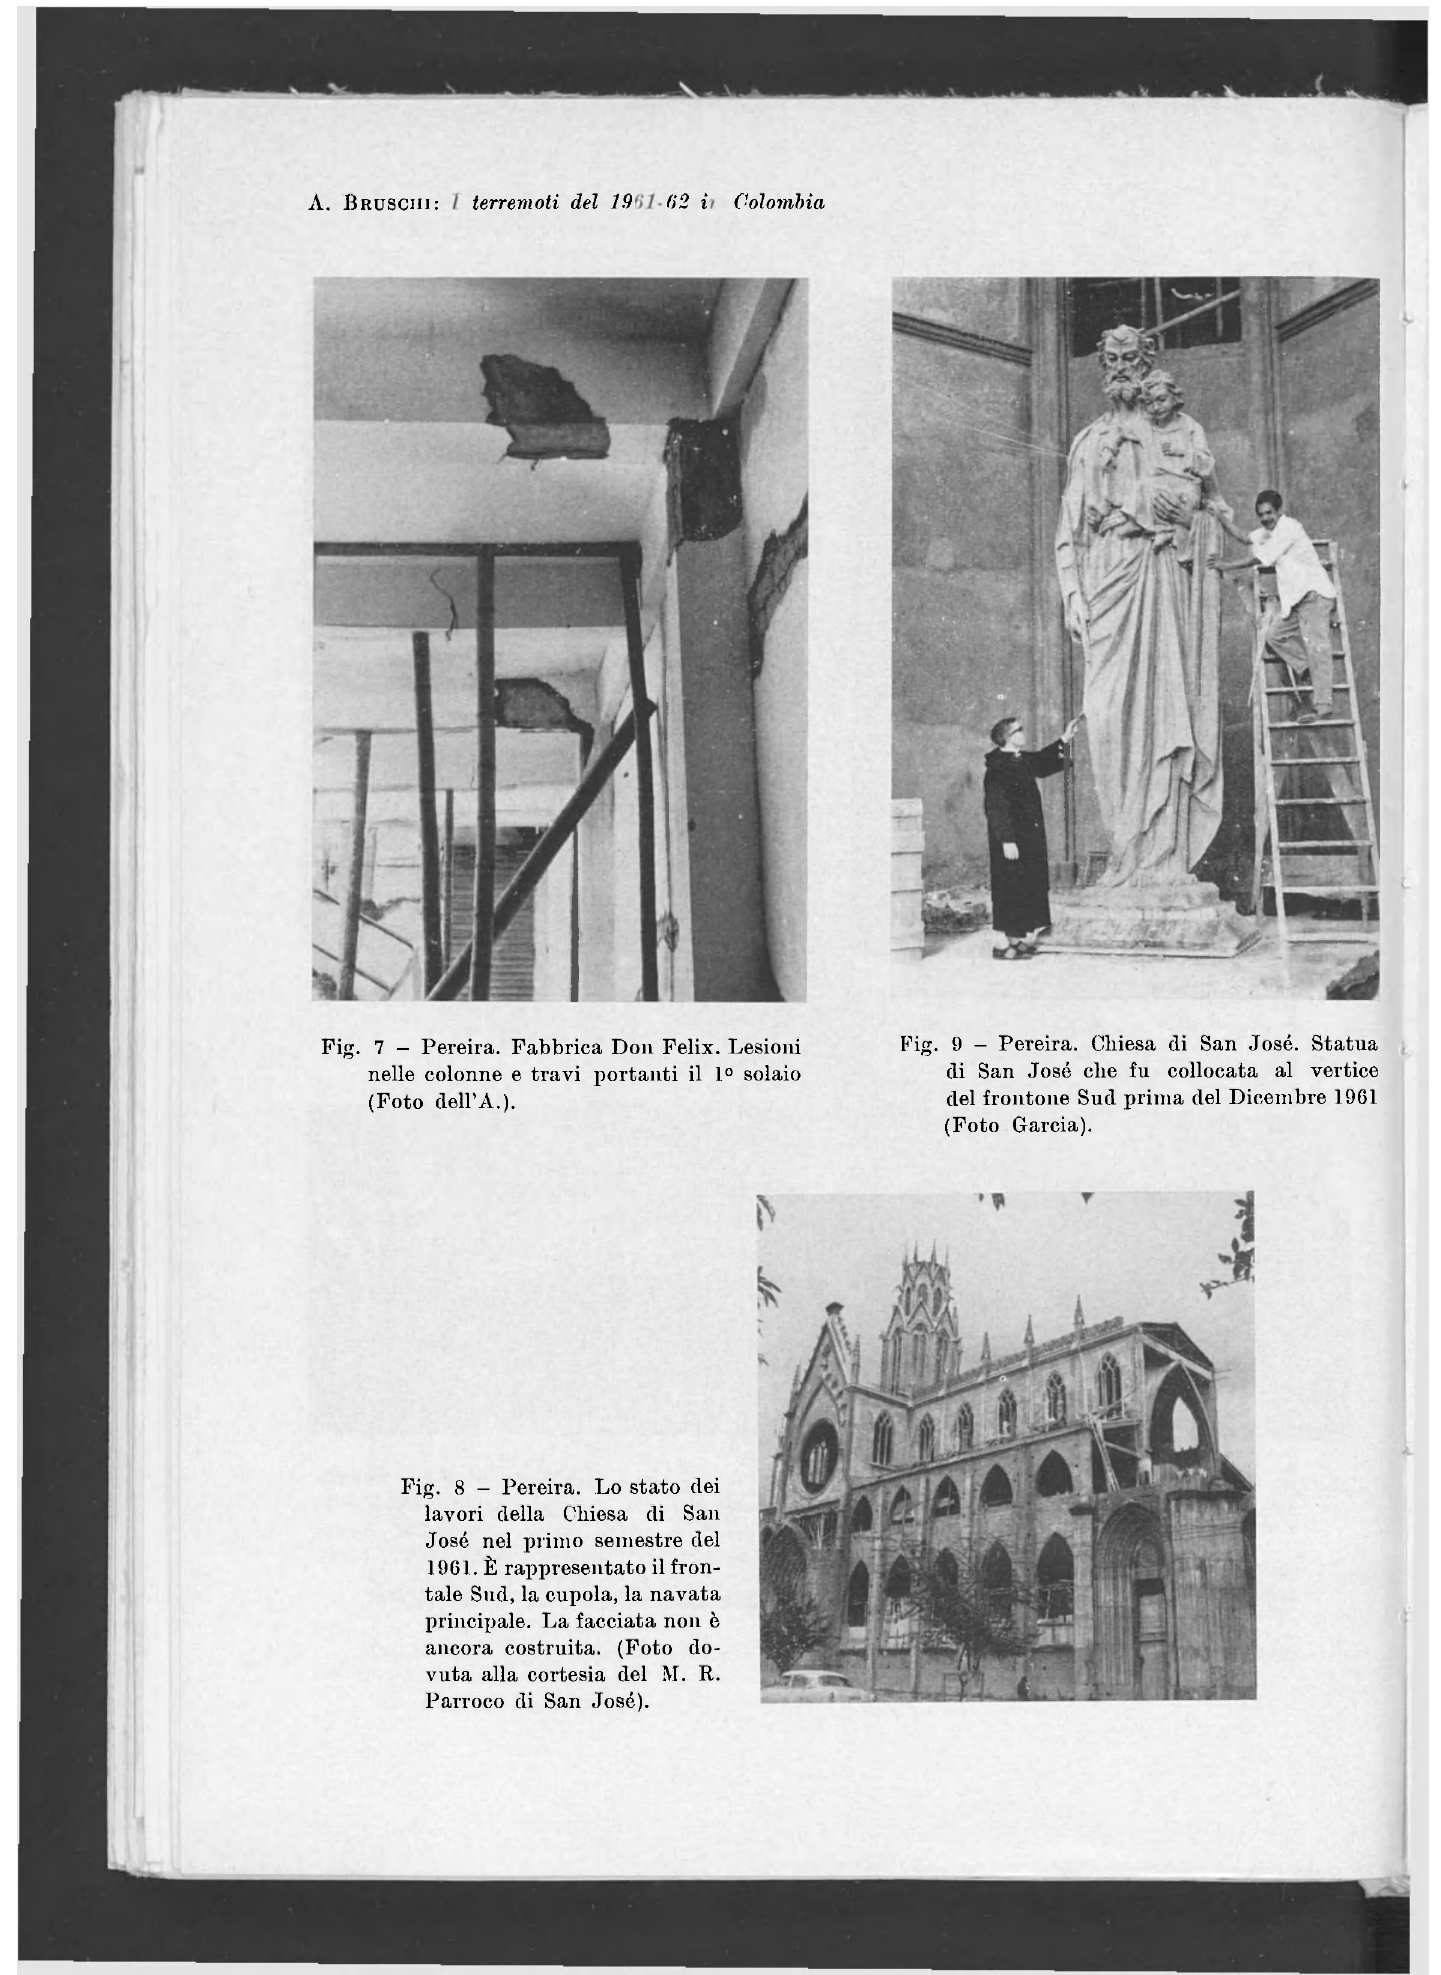
Fig. 7 - Pereira. Fabbrica Don Felix.